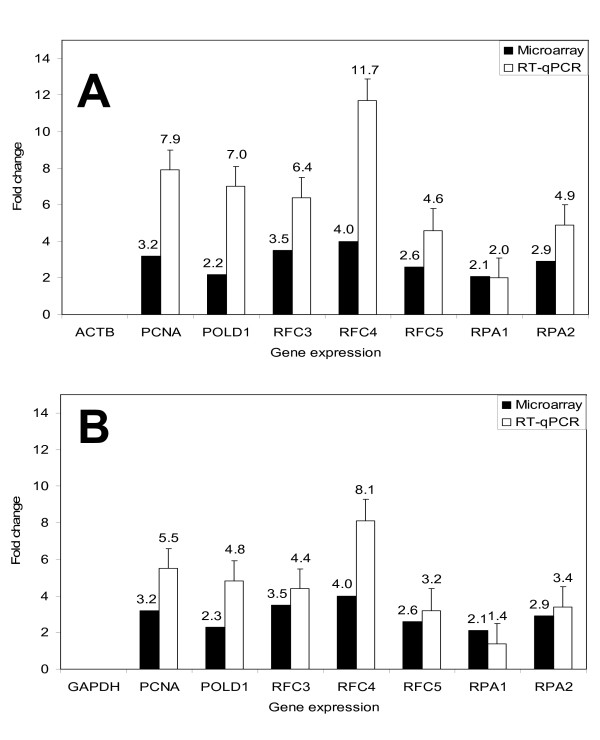
Real-time quantitative PCR analysis (open bars) of genes selected from the microarray (closed bars) in PT3 and Non-PT3. Data are expressed relative to ACTB (3A) and GAPDH (3B) mRNA and (*) presented p < 0.05. The gene expression levels were sorted by detector. Gene expression levels for PT3 are indicated by the black bar. This color also indicates the sample in the RQ sample grid and the RQ results panel plots. Because NK samples are used as calibrator, the expression levels are set to 1. But because the gene expression levels were plotted as log10 values (and the log10 of 1 is 0), the expression level of the calibrator samples appear as 0 in the graph. In addition, because the relative quantities as the targets are normalized against the relative quantities of the reference genes, the expression level of the reference genes is 0, that is, there are no bars for ACTB and GAPDH. Fold-expression changes were calculated using the equation 2-ΔΔCT [5]. Error bars for each column in the plot provided that the associated expression level was calculated from 3 replicates. The error bars display the calculated maximum (RQMax) expression levels that represent standard error of the mean expression level (RQ value). Collectively, the upper and lower limits defined the region of expression within which the true expression level value was likely to occur. The error bars was based on the RQMin/Max confidence level. The number associated with each bar indicates the linear fold-change of mRNA expression in PT3 relative to Non-PT3 for comparison.